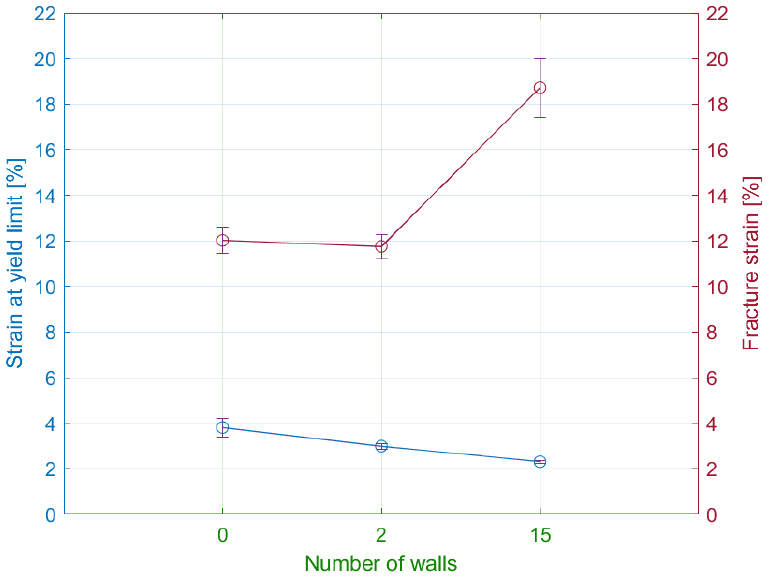
Figure 18. Influence of the number of walls on the strain at yield limit and fracture strain.